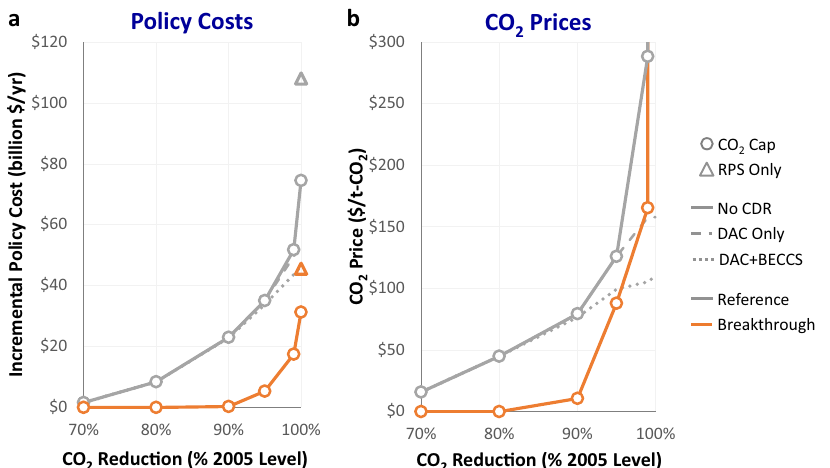
Fig. 5 Economic impacts across different electric sector CO 2 reduction targets (% 2005 levels) and assumptions about CDR availability. Panels show incremental policy costs ( a ) and CO 2 allowance prices ( b ). RPS only limits the choice set of eligible technologies to renewables and energy storage only. Incremental policy costs are the difference between annualized electric sector costs in the scenario with CO 2 caps and a reference scenario without policy. The vertical axis on ( b ) is truncated and omits 100% CO 2 reduction cases with reference and breakthrough technology assumptions, which have CO 2 prices of $849,000/t-CO 2 and $774,000/t-CO 2 , respectively. Source data are provided as a Source Data fi